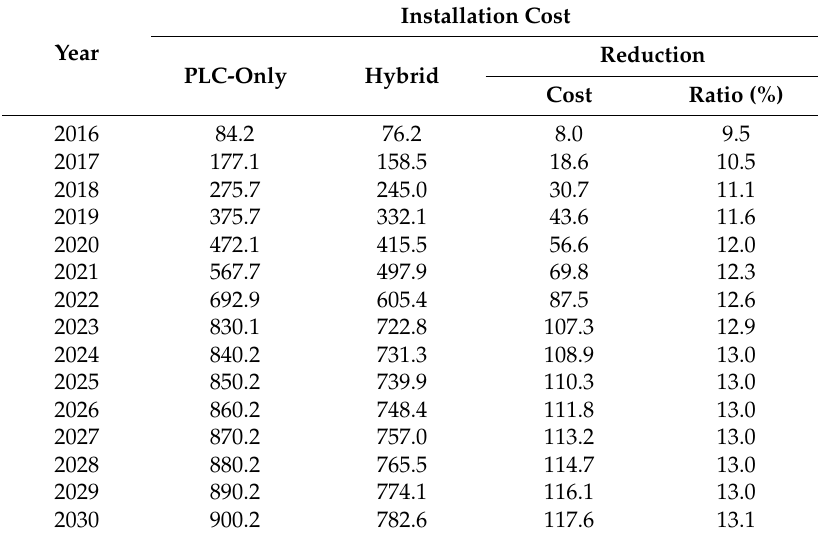
Table 5. Comparison of Installation Cost Result per Deployment Method (Billion KRW).